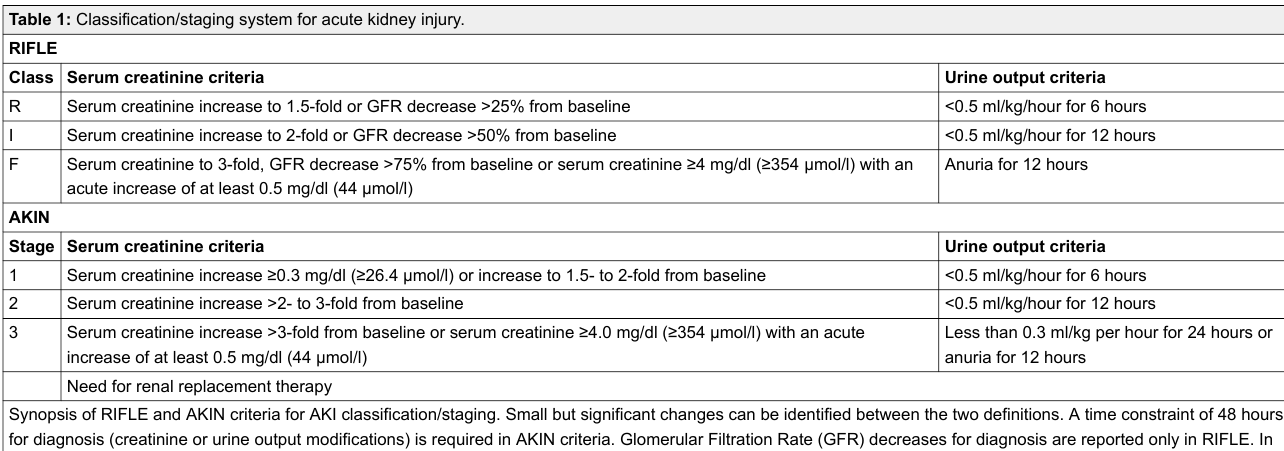
Need for renal replacement therapy Synopsis of RIFLE and AKIN criteria for AKI classification/staging. Small but significant changes can be identified between the two definitions. A time constraint of 48 hours for diagnosis (creatinine or urine output modifications) is required in AKIN criteria. Glomerular Filtration Rate (GFR) decreases for diagnosis are reported only in RIFLE. In both cases, only one criterion (creatinine or urine output) has to be fulfilled to qualify for a class/stage. Classes L (loss of function) and E (end stage kidney disease) of RIFLE criteria are not reported in AKIN. Given wide variation in indications and timing of initiation of renal replacement therapy (RRT), individuals who receive RRT are considered to have met the criteria for AKIN stage 3 irrespective of the stage they are in at the time of